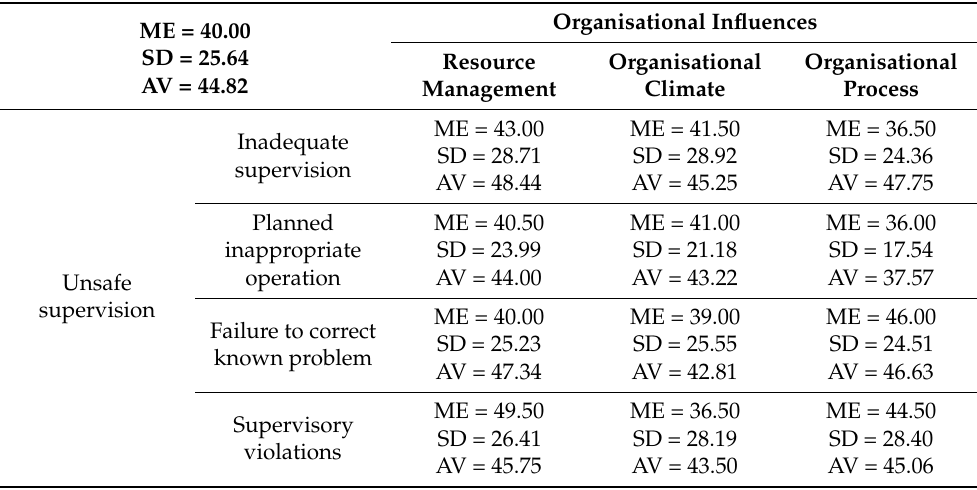
Table A2. Median (ME), standard deviation (SD), and average (AV) for responses on Stage 2 (how Organisational influences affect the occurrence of Unsafe